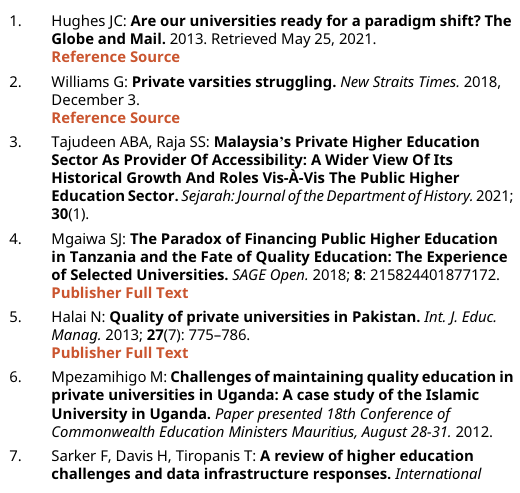
This project contains the following underlying